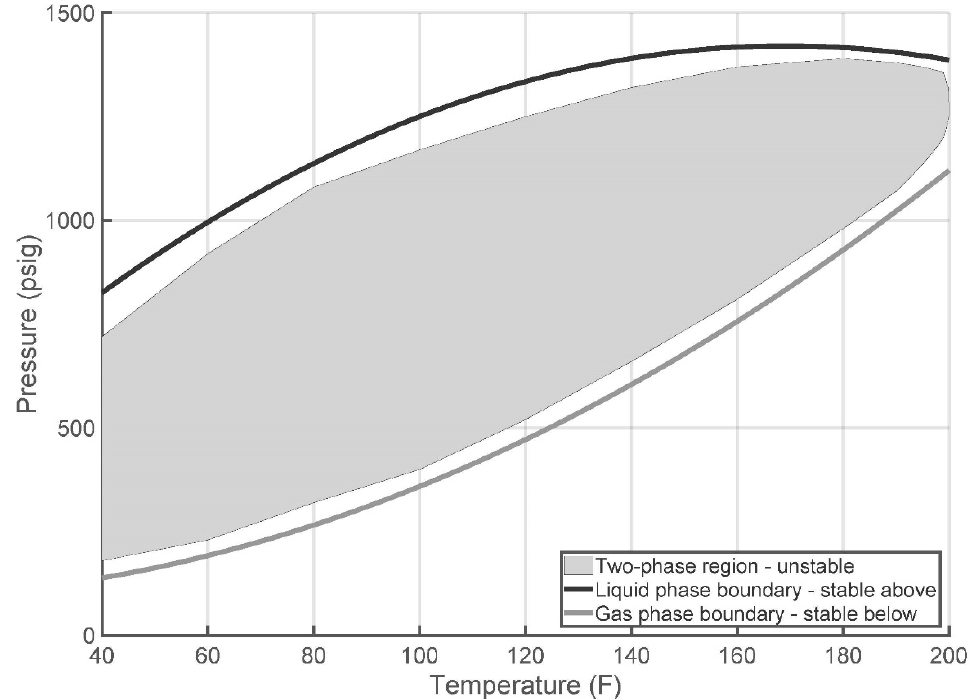
Figure 4. Simple boundaries.